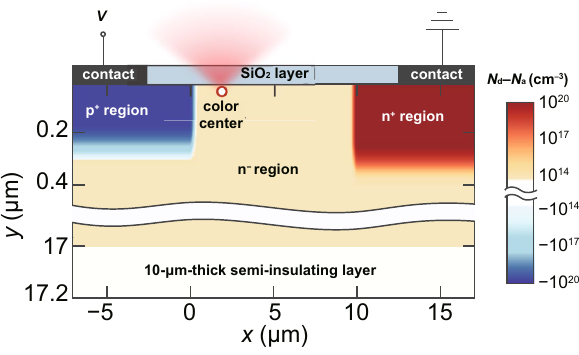
Fig. 1 Schematic of the single-photon emitting diode based on a color center in a lateral 4H-SiC p + –n − –n + diode and spatial distribu- tion of donors and acceptors in the